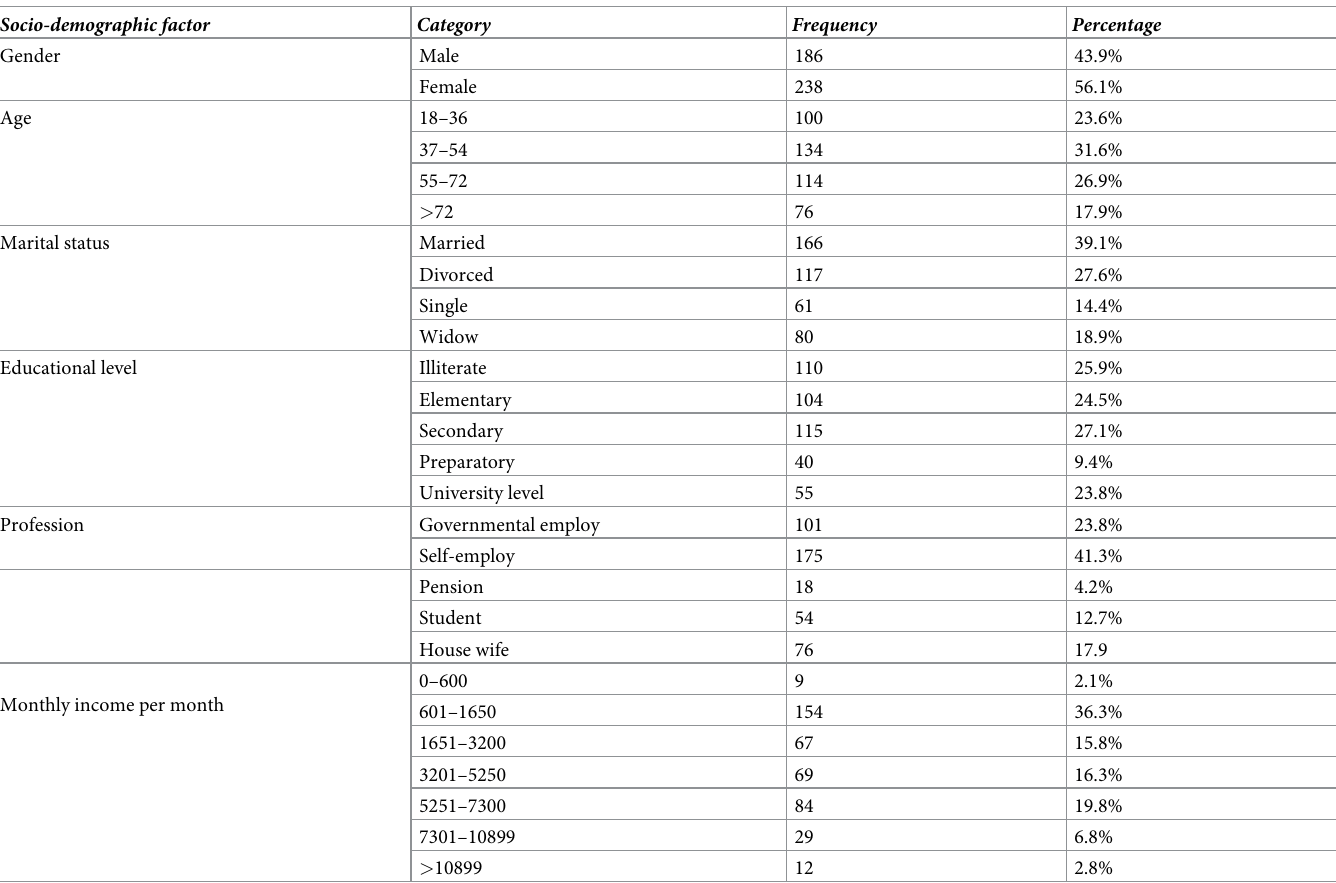
Table 1. Socio-demographic characteristics of heart failure patients attending cardiac follow-up clinic at selected government hospitals in Addis Ababa, Ethiopia. (n = 424). Socio-demographic factor